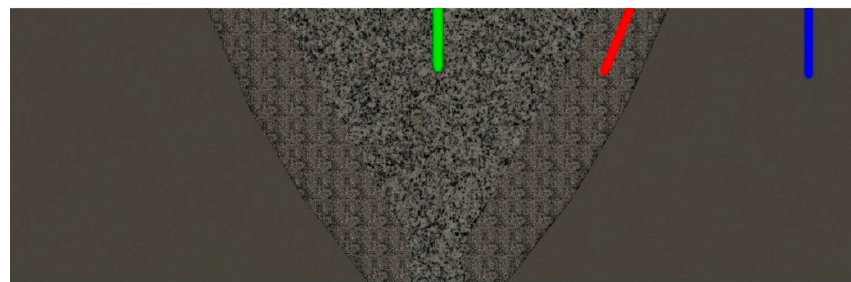
Figure 7. Position of measured residual stresses in the welded joint.